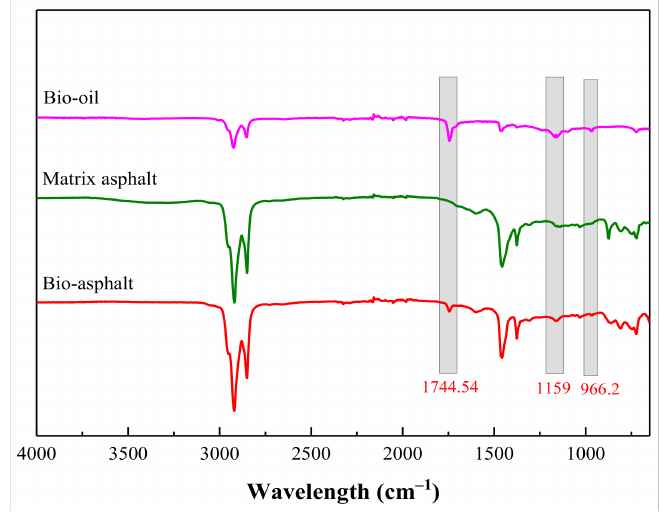
Figure 17. Infrared spectroscopy of bio-oil, matrix asphalt and bio-asphalt.